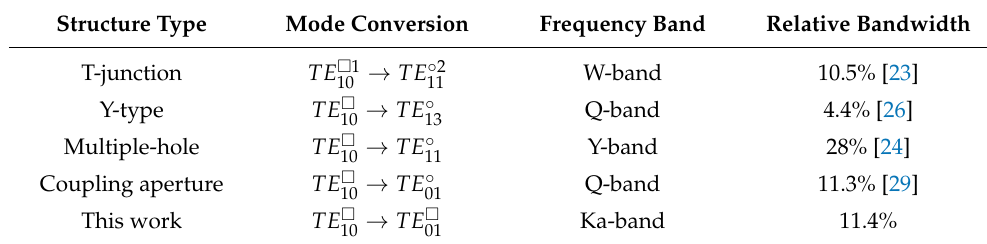
Table 1. Performance comparison of different mode converters.